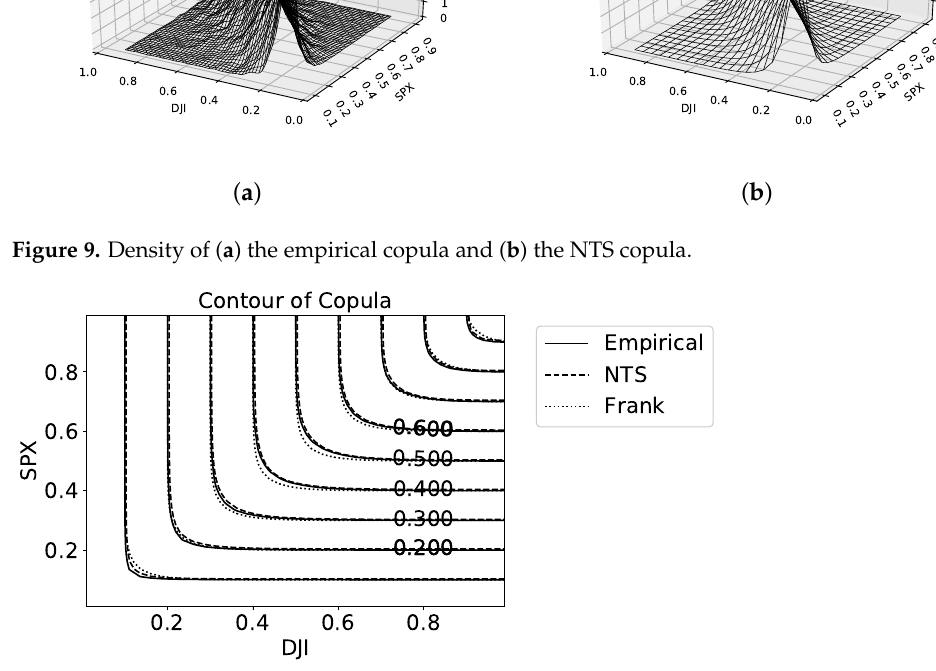
Figure 10. Contour plot of the copula estimated by different copulas. Table 2. Two-dimensional test